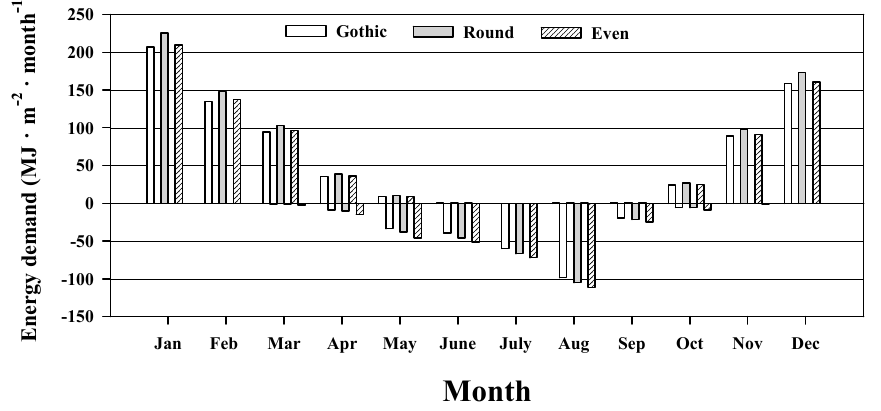
Figure 10. Comparison of the monthly heating and cooling energy demands for selected greenhouse roof shapes.